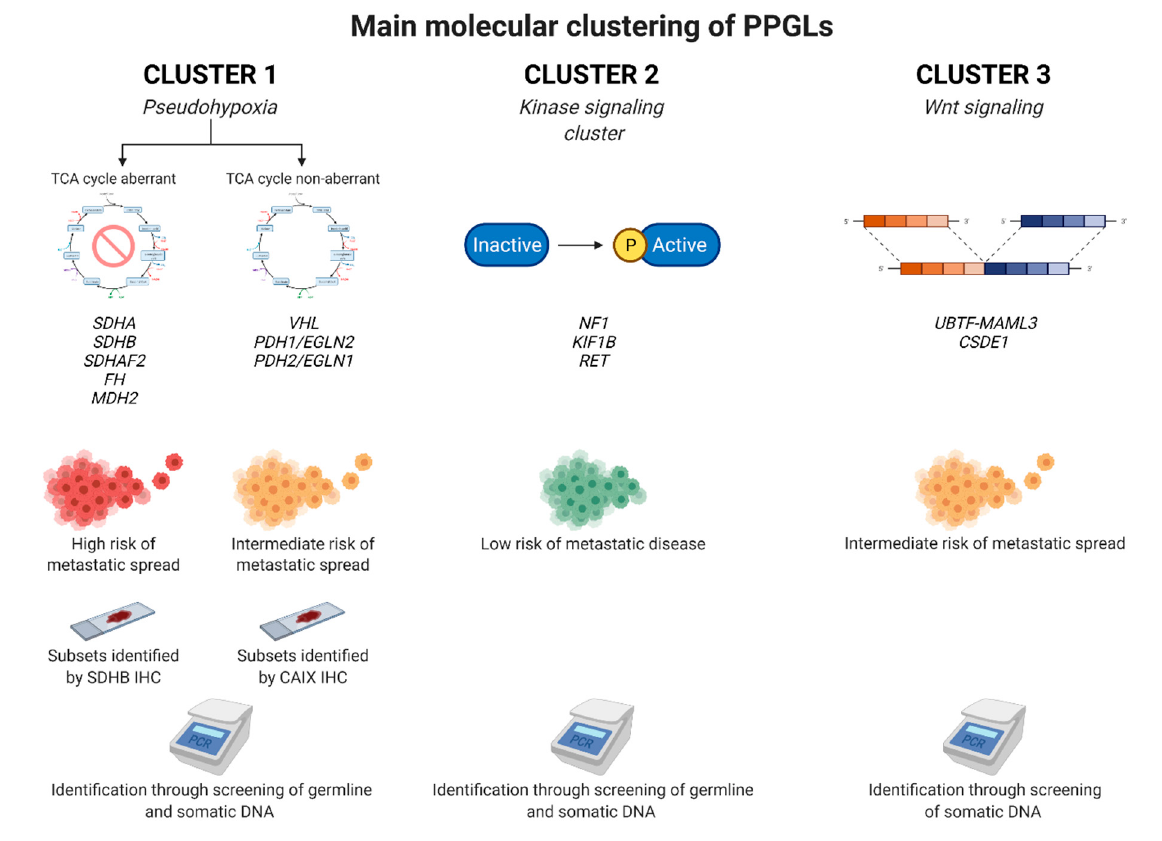
Figure 4. Main molecular clustering of pheochromocytomas and paragangliomas (PPGLs). Tumors are traditionally divided into four main transcriptomal clusters depending of the mRNA profiles, of which three are detailed here with a representative set of specific genes highlighted for each